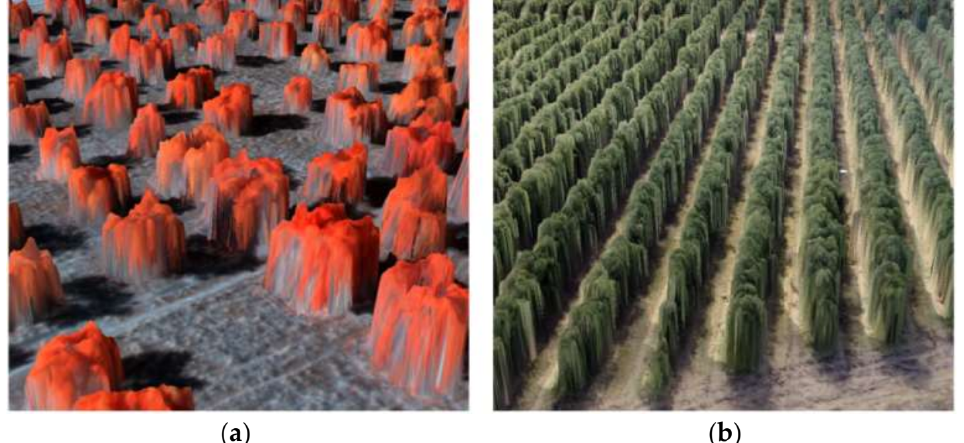
Figure 3. 3D representation of a traditional plantation generated with a multispectral sensor ( a ) and a row plantation generated with a visible light camera ( b ). Data from